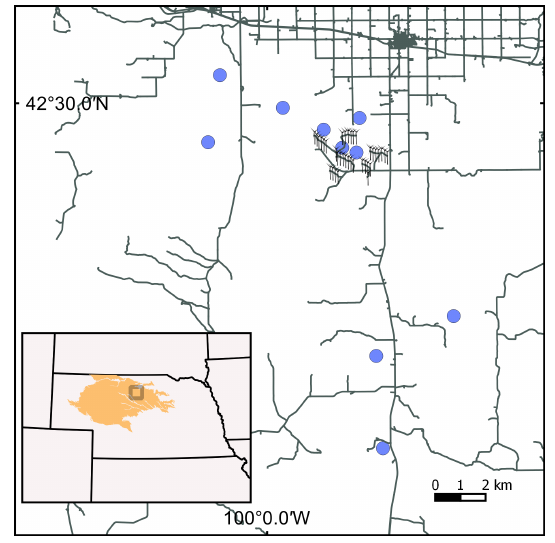
Fig. 1 . Location of the study area near Ainsworth, Brown County, Nebraska, USA (42.455ºN, 99.915ºW), on the northeastern edge of the Nebraska Sandhills ecoregion (inset; study site in gray square). Approximate locations of Greater Prairie-Chicken ( Tympanuchus cupido ) leks used for recordings in this study are marked by blue